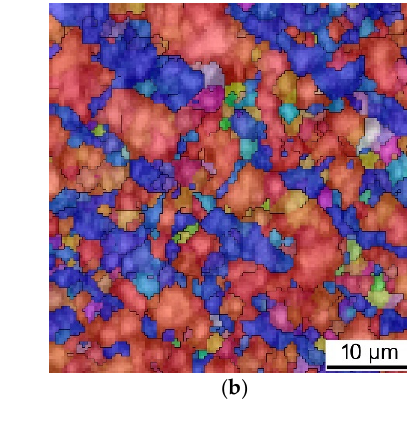
Figure 6. SEM OIM images for Cu lamellas of swaged laminate ( a ); HT1 laminate ( b ); HT2 laminate ( c ); OIM legend ( d ).